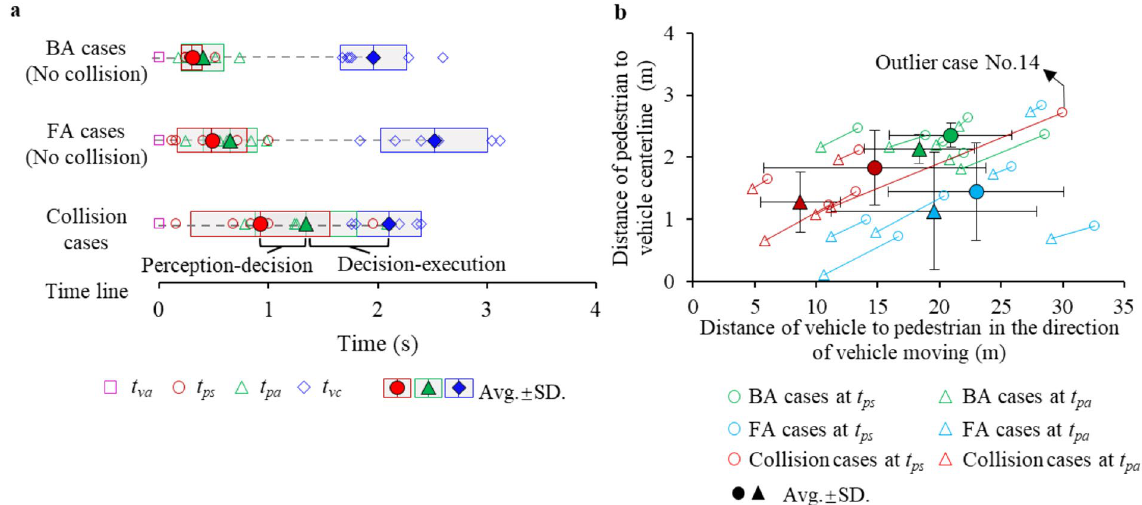
Figure 4. The avoidance process of pedestrians relative to the “bullet vehicle”: ( a ) the reaction timeline of pedestrian in the BA cases, FA cases (collision avoided) and collision cases subject to the manual trigger of the “bullet vehicle” by the experimenter; ( b ) the relative location of the pedestrian and the “bullet vehicle” at t ps (danger perceived) and t pa (decision made); the same case is connected by a solid line; the centre of the vehicle front-end is taken as the coordinate